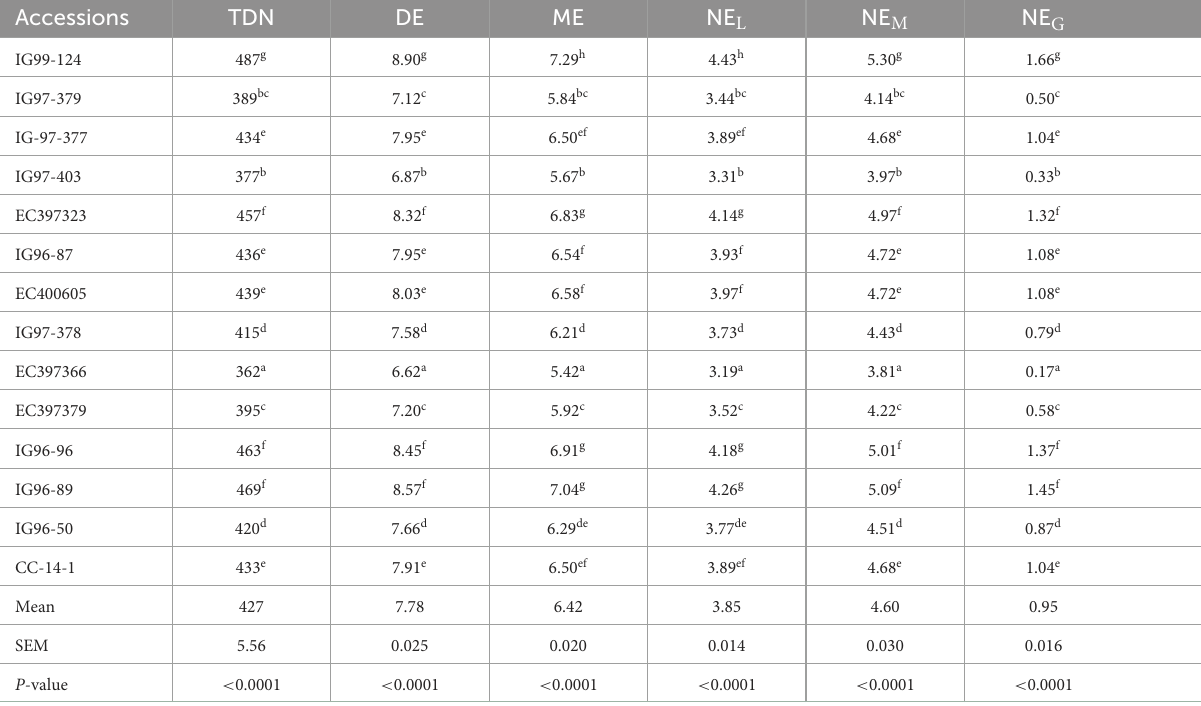
TABLE 5 Energy contents of sugar-rich Cenchrus ciliaris accessions.